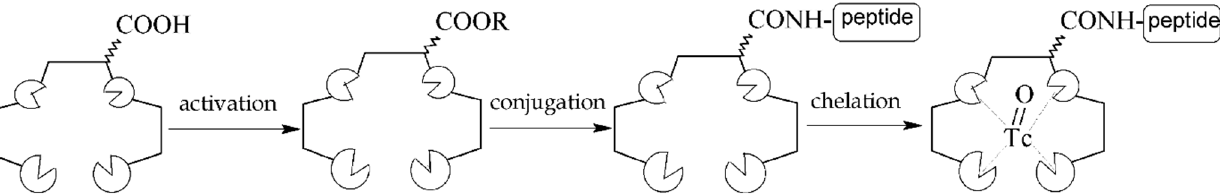
Figure 6. Scheme of the post-labeling procedure with technetium-99m (adapted according to [3]). Technetium chemistry, its cores and complexes, have been thoroughly reviewed in